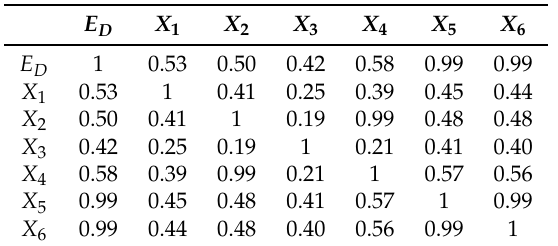
Table 6. Correlation of performance monitoring computers (PMCs) with dynamic energy consumption ( E D ). Correlation matrix showing relationship of dynamic energy with PMCs. 100% correlation is denoted by